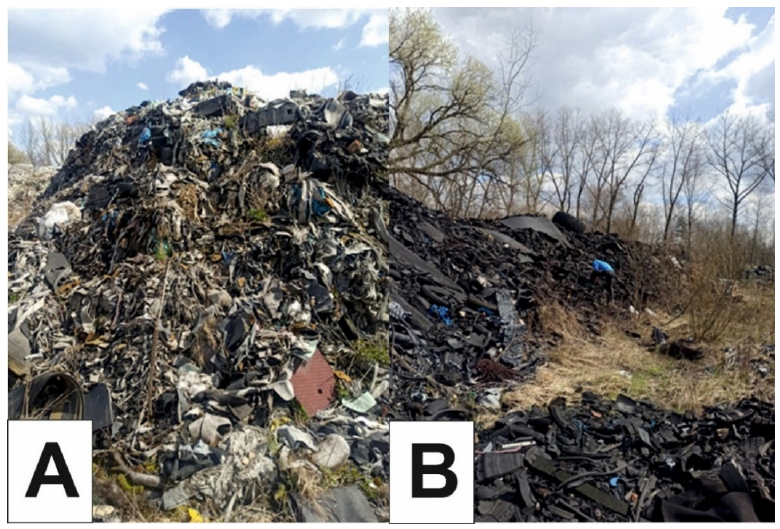
Figure 2. ( A , B ) The present site of the burnt wild waste dump in Trzebinia on S ł owackiego Street (April 2021).